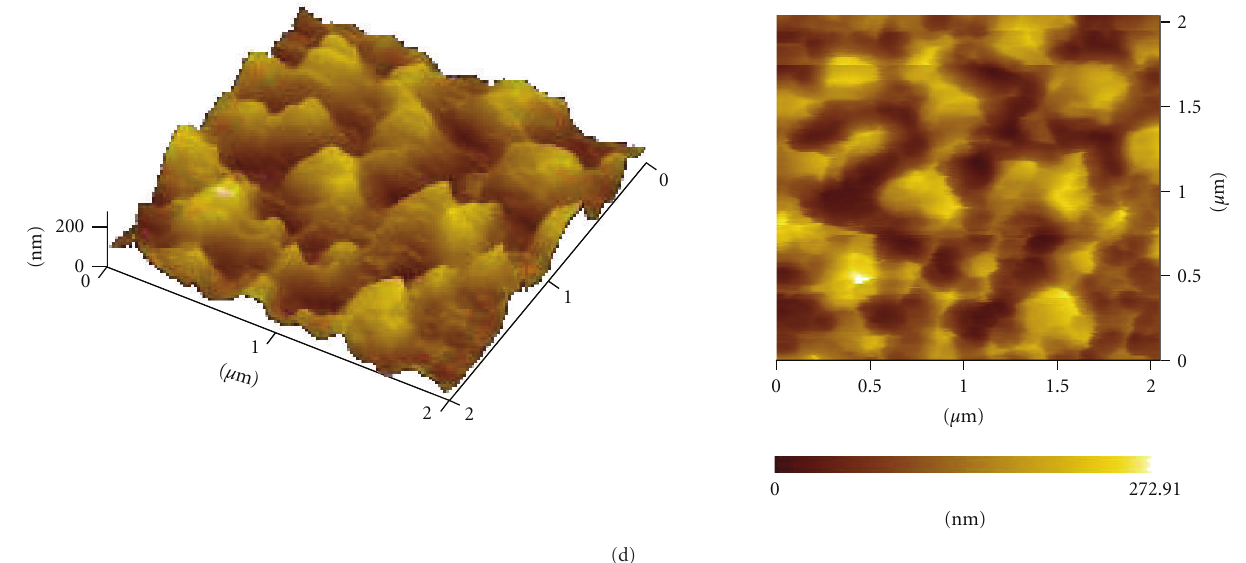
Figure 5: AFM 3D- and 2D- micrographs of Ag-Cu-O films formed at di ff erent substrate temperatures: (a) 303 K, (b) 373K, (c) 473 K, and (d) 523 K.